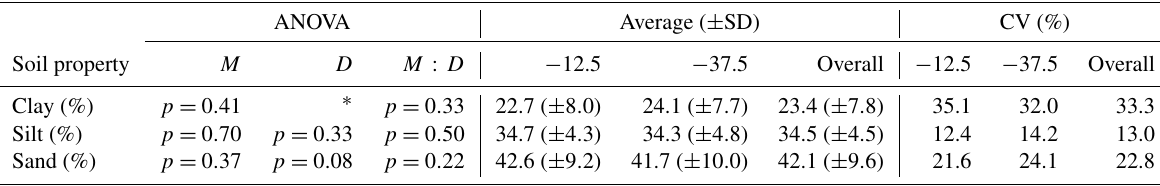
Table 1. Effects of management system ( M ), sampling depth ( D ) and their interaction ( M : D ) on soil texture, analysed with linear mixed models (Eq. 1) followed by analysis of variance (ANOVA). ∗ indicates significant effects at p< 0 . 01. Average values for the different depths represent means of three management systems (no-till, conventional, organic and n = 10).